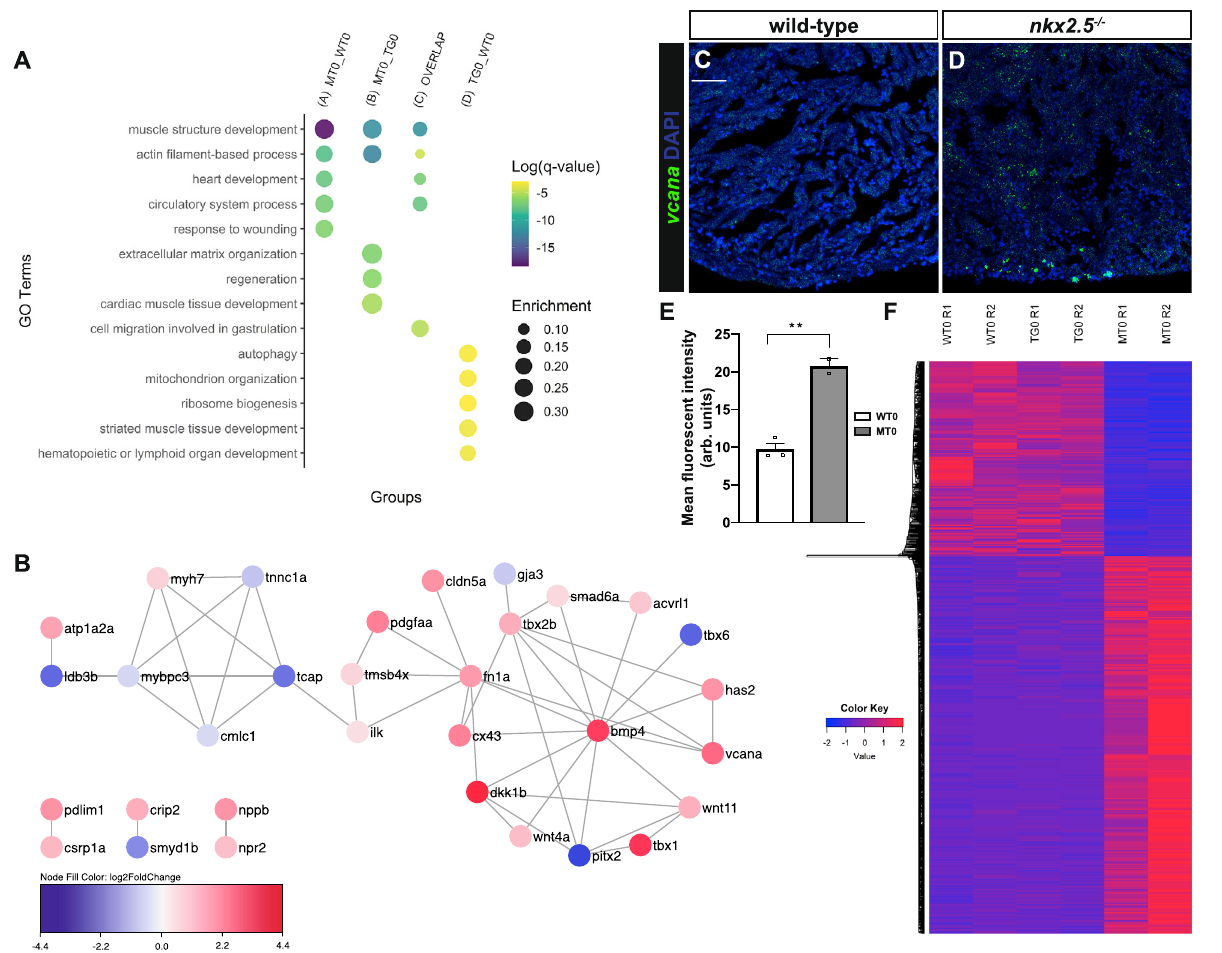
Fig. 2 Developmental transcriptional pathways are disrupted in the adult nkx2.5 − / − myocardium. A Gene Ontology (GO) analysis of all the DEGs in groups A, B, C, D from Fig. S1. The fi ve most signi fi cantly enriched GO terms are selected for each comparison. Color and size of circles correspond to log (q-value) and enrichment, respectively. B Network analysis of genes associated with the enriched GO term, heart development, from the ‘ overlap ’ set (group C). Color represents the fold change comparisons between nkx2.5 − / − and wild-type hearts (MT0 vs WT0). Red is upregulated and blue is downregulated, as shown in the key. C , D Representative images of RNAscope in situ hybridization analysis on sections from uninjured hearts employing a probe directed against vcana highlight upregulation in nkx2.5 − / − compared to wild-type myocardium. Scale bar, 50 μ m. E Quanti fi cation of integrated signal density of vcana is depicted in wild-type ( n = 3) and nkx2.5 − / − ( n = 2) hearts. Mean and standard error of each data set are shown. Unpaired, two- tailed t -test yields a statistically signi fi cant difference between WT0 and MT0 ( p = 0.0031). F Hierarchical clustering heatmap analysis of DEGs ( n = 1071) noted in the ‘ overlap ’ set (group C). The Z -scores of gene expression measurements are displayed as colors ranging from blue to red. The rows are clustered using Euclidean distance measures and average linkage. Source data are provided as a Source Data fi